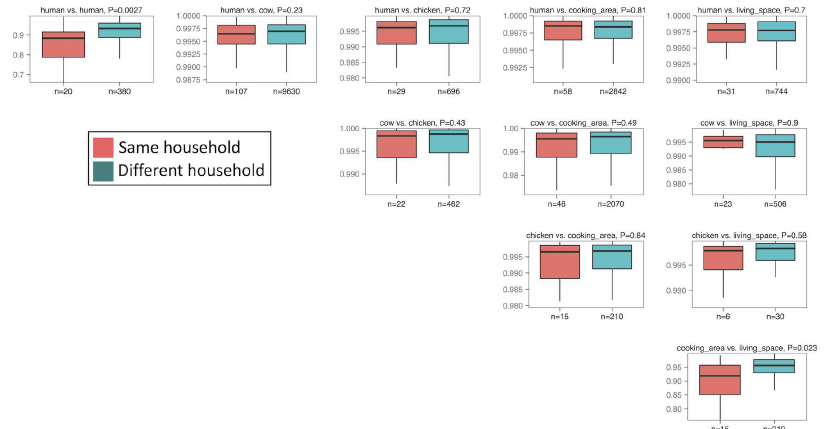
Fig 3. Pairwise comparisons of the distribution of Bray-Curtisabundance distance metrics comparing samples within and between households in western Kenya. Childrenwithin the same household and surfaces within the same householdshow significantly similar